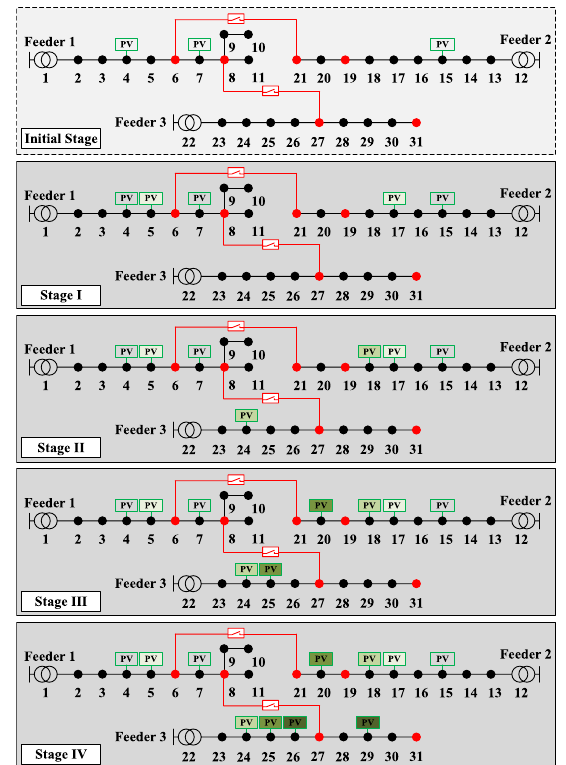
Fig. 3 Structure of the modified practical distribution network